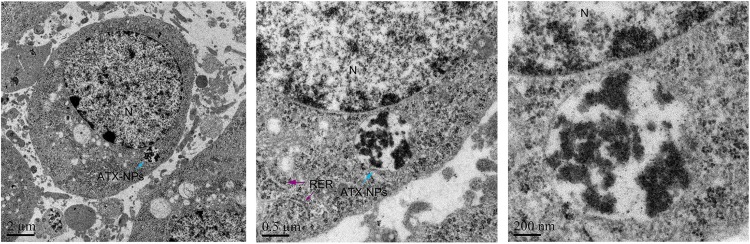
TEM photographs showed uptake of ATX-NPs in the cytoplasm of neurons. Scale bars are 2 μm, 0.5 μm, and 200 nm.